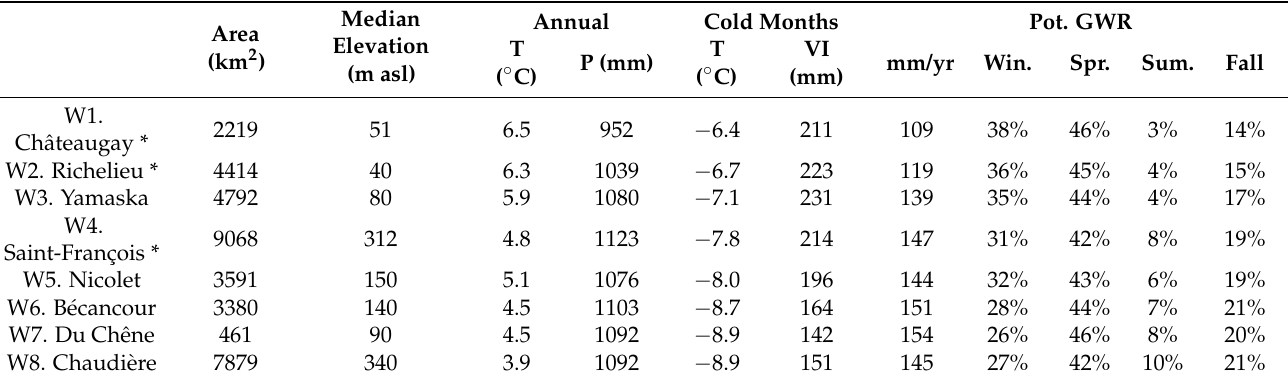
Table 1. Watershed characteristics, climate, and potential groundwater recharge (GWR) for the 1961–2017 period (from